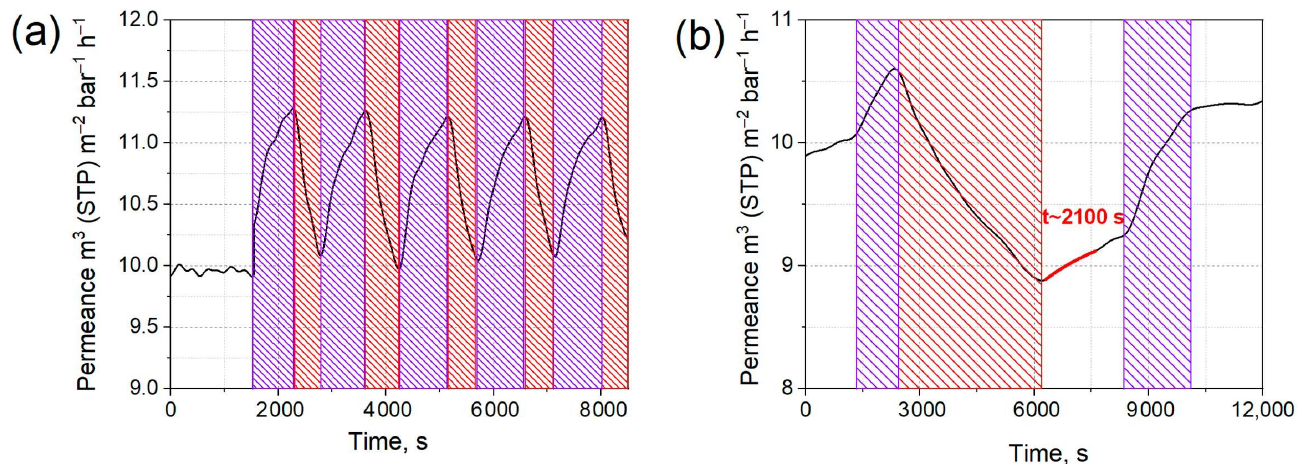
Figure 2. Water vapor permeance of azo-GO membrane subjected to UV (365 nm)/IR (850 nm) irradiation ( a , b ). The measurements were performed at feed stream relative humidity of 75%, 1 bar and 25 °C. Violet shaded areas indicate UV light irradiation periods; red shaded areas correspond illumination of membrane with IR light.